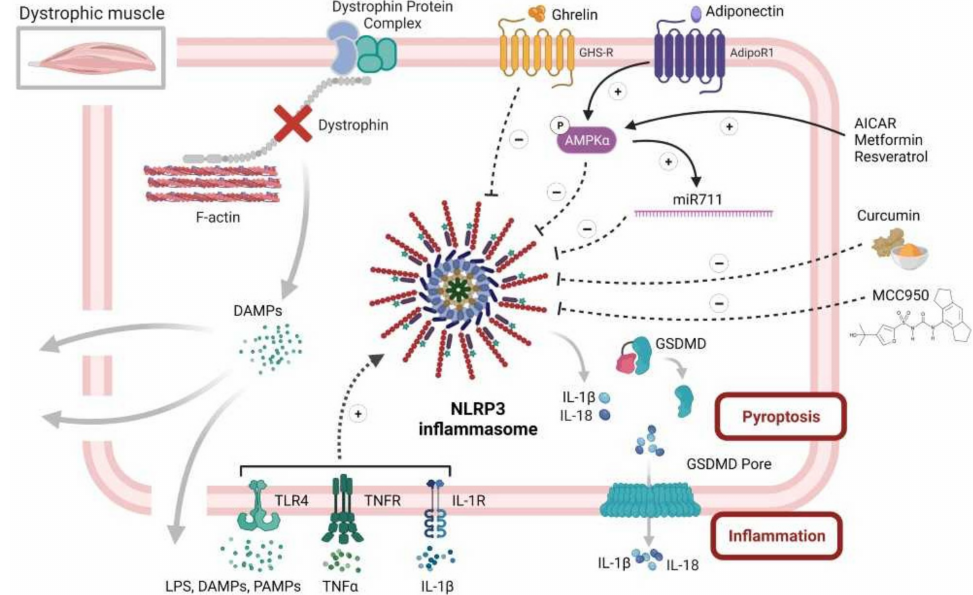
Figure 6. NLRP3 inflammasome and diseased skeletal muscle, case of Duchenne muscular dystrophy. This figure summarizes the central role of NLRP3 in dystrophic muscle inflammation, as well as several of its potential inhibitors. Briefly, the dystrophic muscle is characterized by absence of the dystrophin protein and its associated protein complex, which, in normal cells, links the intracellular cytoskeleton to the extracellular matrix, thus preserving the fiber membrane stability and permeability. Simple contraction of the dystrophic muscle causes microtears in the membrane and the subsequent release of intracellular DAMPS, which, in turn, can act in an autoparacrine manner to activate NLRP3 inflammasome in muscle fibers. Activated NLRP3 leads to an extreme release of inflammatory cytokines and DAMPS, thus maintaining and exaggerating the inflammatory response, eventually leading to pyroptosis and muscle degeneration. Rescuing the dystrophic phenotype can be achieved by alleviating muscle inflammation, in part through repression of NLRP3 inflammasome. This action can be accomplished by several factors. Firstly, adiponectin, a pleiotropic adipokine with potent anti-inflammatory effects, could strongly activate AMPK pathway that represses NLRP3 through reducing NF- κ B activity and oxidative stress. Secondly, adiponectin, also through AMPK, increases the expression of its muscle anti-inflammatory mediator, miR-711, which can inhibit both the priming and activation of NLRP3. Thirdly, several drugs and molecules, such as AICAR, resveratrol and metformin, could repress NLRP3 through specific activation of the AMPK pathway. Fourthly, ghrelin, a gastric peptide with anti-inflammatory effect, could also put a brake on muscle inflammation through reduction in NLRP3 activation. Fifthly, curcumin, a potent NF-kB inhibitor, could hinder NLRP3 and the production of inflammatory cytokines. Finally, MCC950, a specific NLRP3 inhibitor, could greatly attenuate the pathogenesis of the dystrophic phenotype, mainly by protecting the muscle from inflammation. Symbols in circles indicate: ‘P’, phosphorylation; ‘+’, activation; and ‘ − ’,